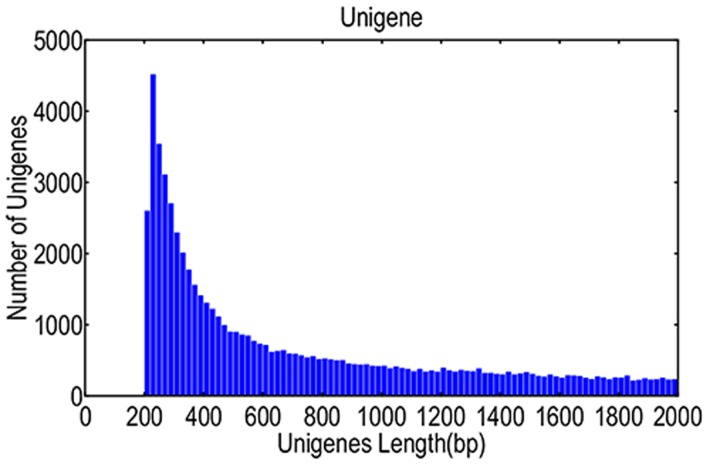
Sequence size distribution and the number of sequences of each length in the assembly (shown on the y-axis).